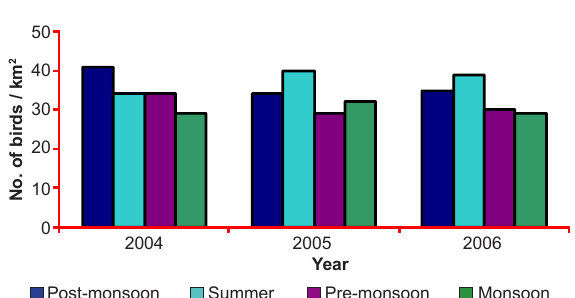
Figure 1. Habitat-wise variations in the density of the Indian Roller in agricultural lands from 2004 to 2006